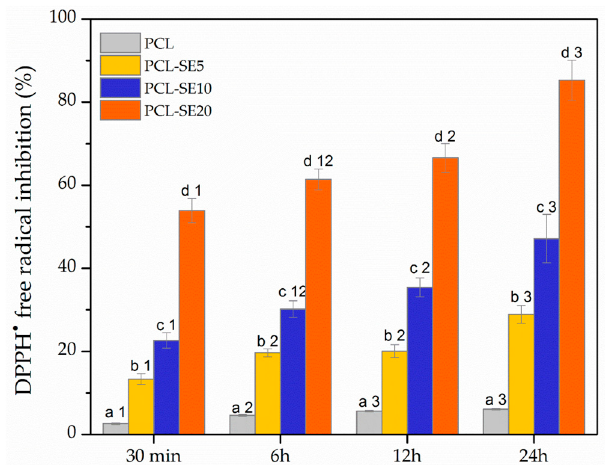
Figure 5. Antioxidant activity, expressed as DPPH · free radicals scavenging ability of the PCL-based films. Different letters indicate significant difference among different films at certain incubation time ( p < 0.05). Different numbers indicate significant difference of the same sample at different incubation time ( p < 0.05).